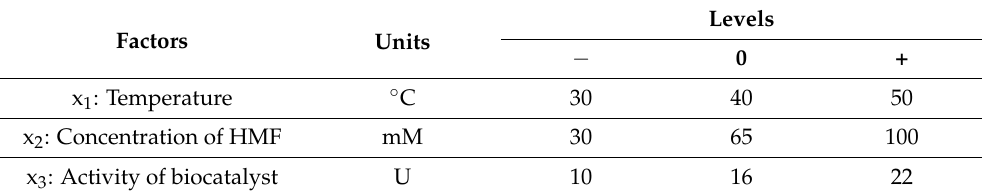
Table 5. Independent experimental variables for the optimization of conversion. Factors Units